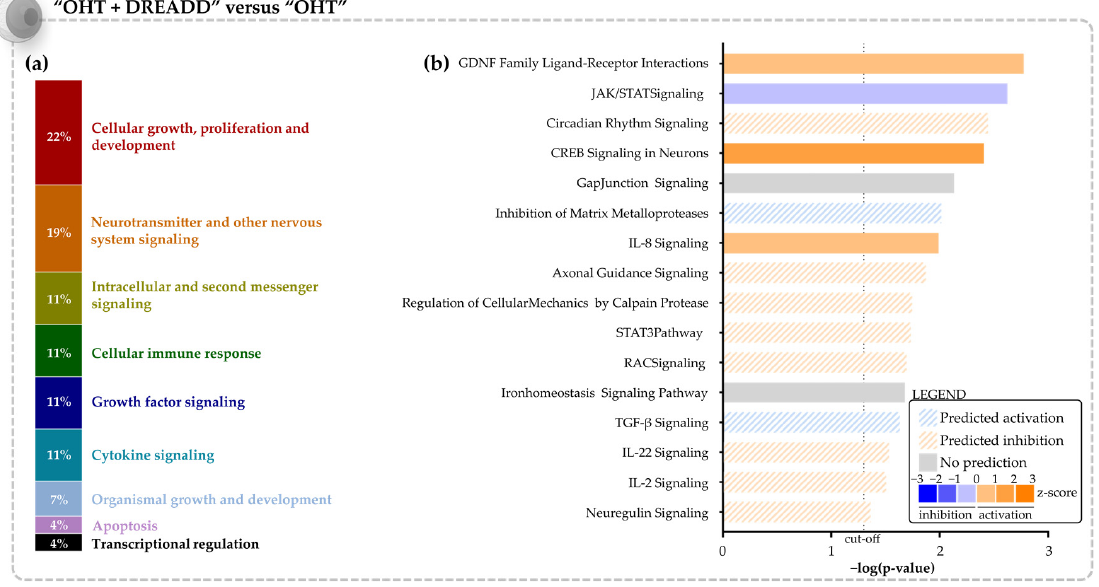
3 Figure 8. Canonical Pathway analysis in the “OHT + DREADD” vs. “OHT” dataset of the RGC transcriptome. ( a ) Overarching categories to which the altered canonical pathways belong. ( b ) List of the altered signaling pathways, relevant to the biological question (FDR ≤ 0.1, − log ( p -value) ≥ 1.30, Fisher’s exact test). A list of all significantly altered canonical pathways is provided in Supplementary File S4. IPA predictions are algorithm- (based on z-score, filled bars) or user-defined (striped bars). Pathways that are predicted to be upregulated are shown in orange, those predicted downregulated in blue. A grey bar indicates that no prediction could be